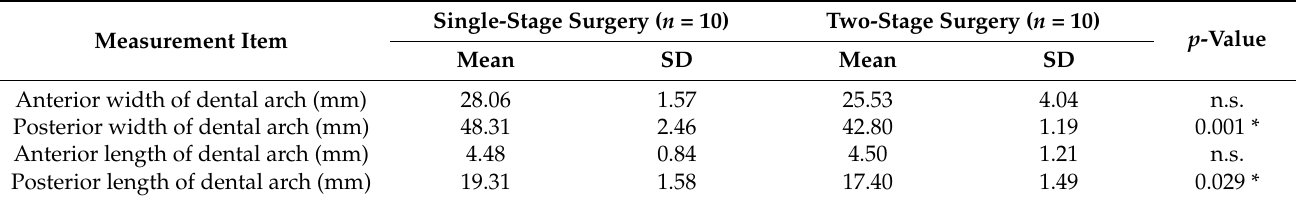
Table 2. Analysis results of the dentition